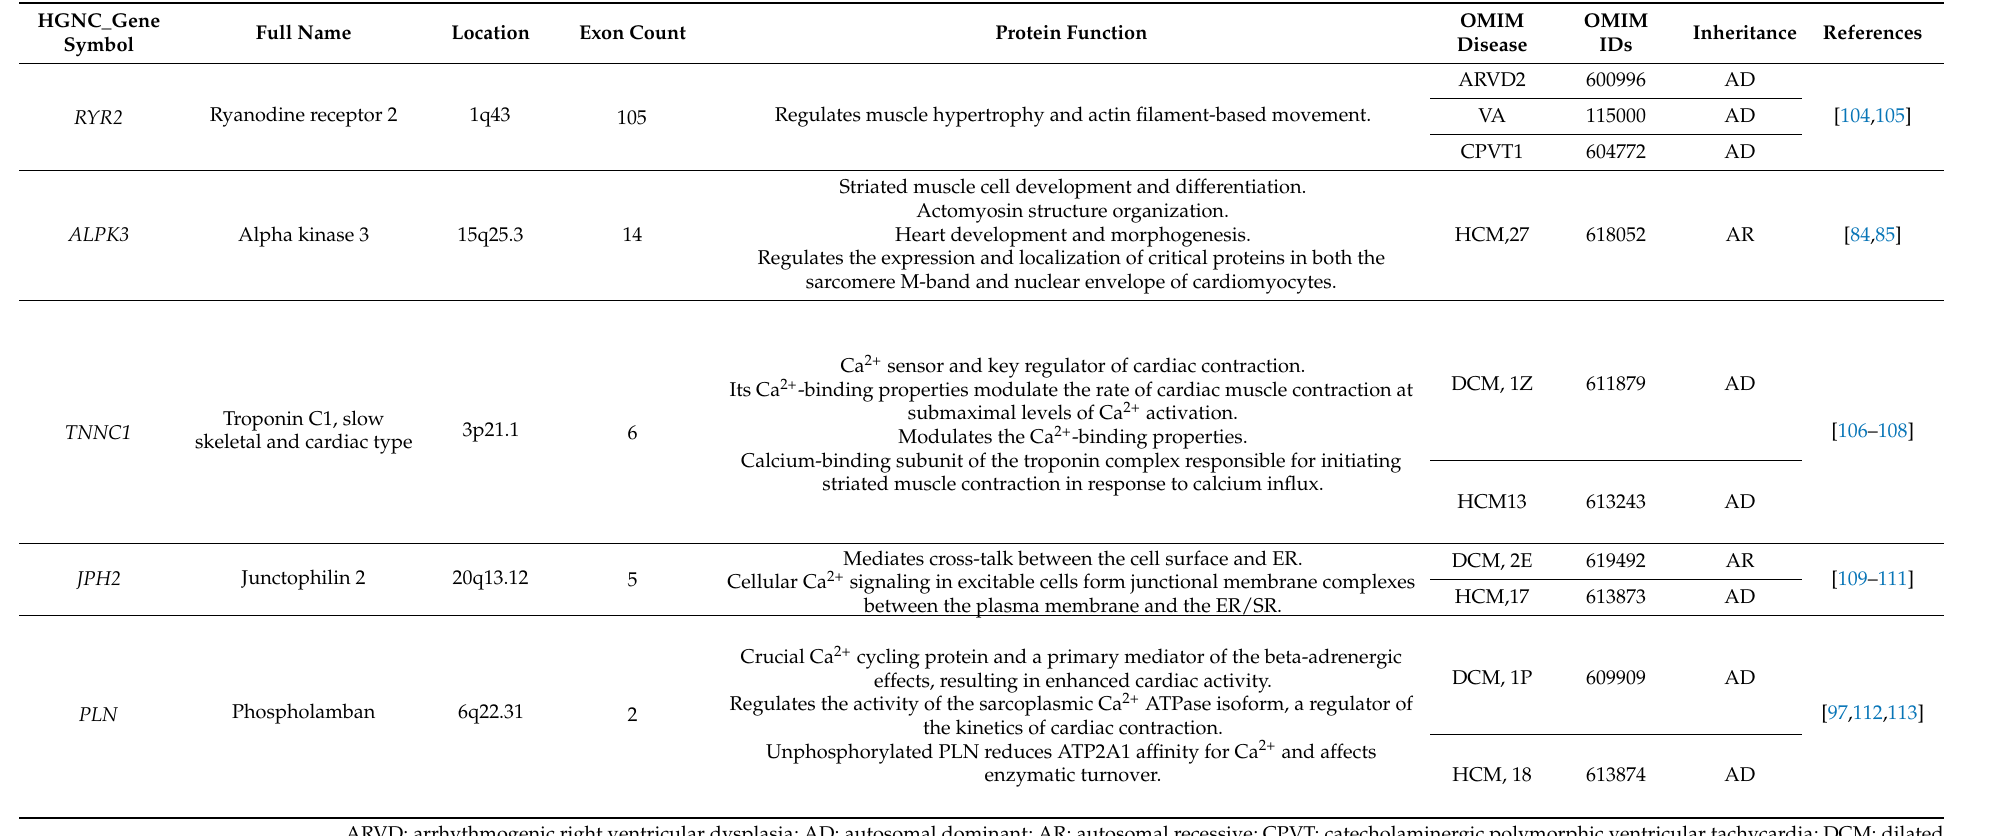
Table 2. Calcium-related genes linked to hypertrophic